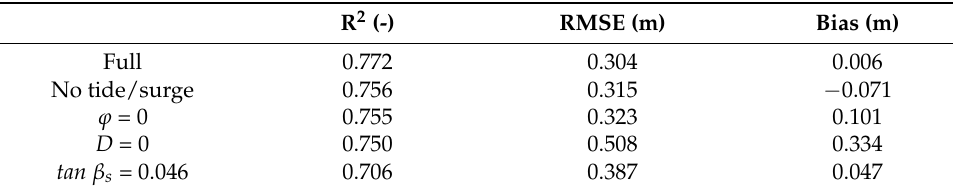
Table 3. Effects of omitting input parameters on error